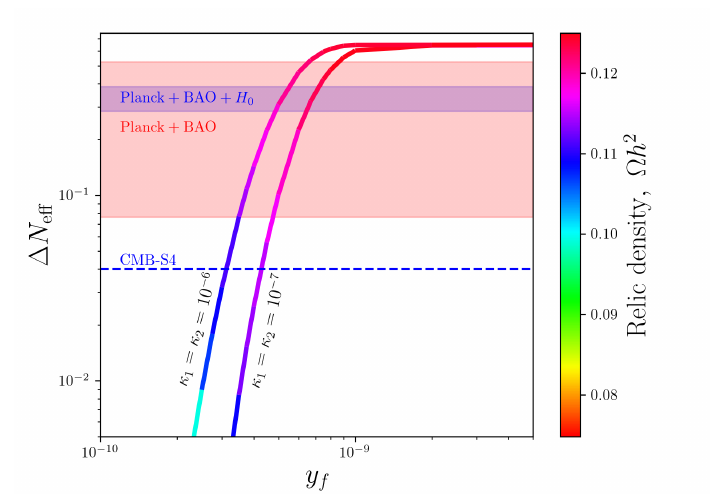
Figure 9. A plot of ∆ N eff for the case of massless φ 3 as a function of y f for sets of values of κ 1 and κ 2 . The color gradient of the curves reflects the DM relic density. Other input parameters are same as in figure